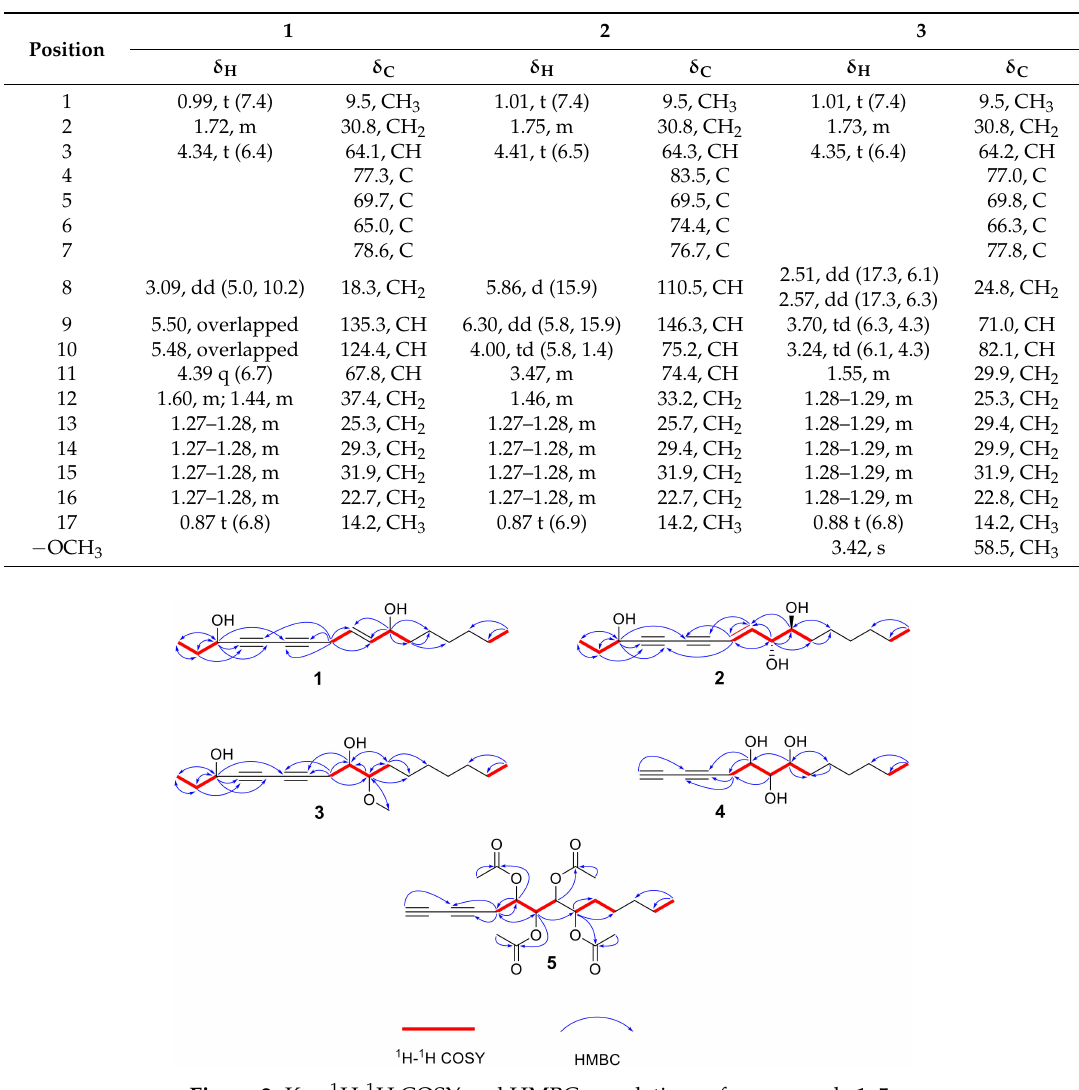
Figure 2. Key 1 H- 1 H COSY and HMBC correlations of compounds 1 – 5